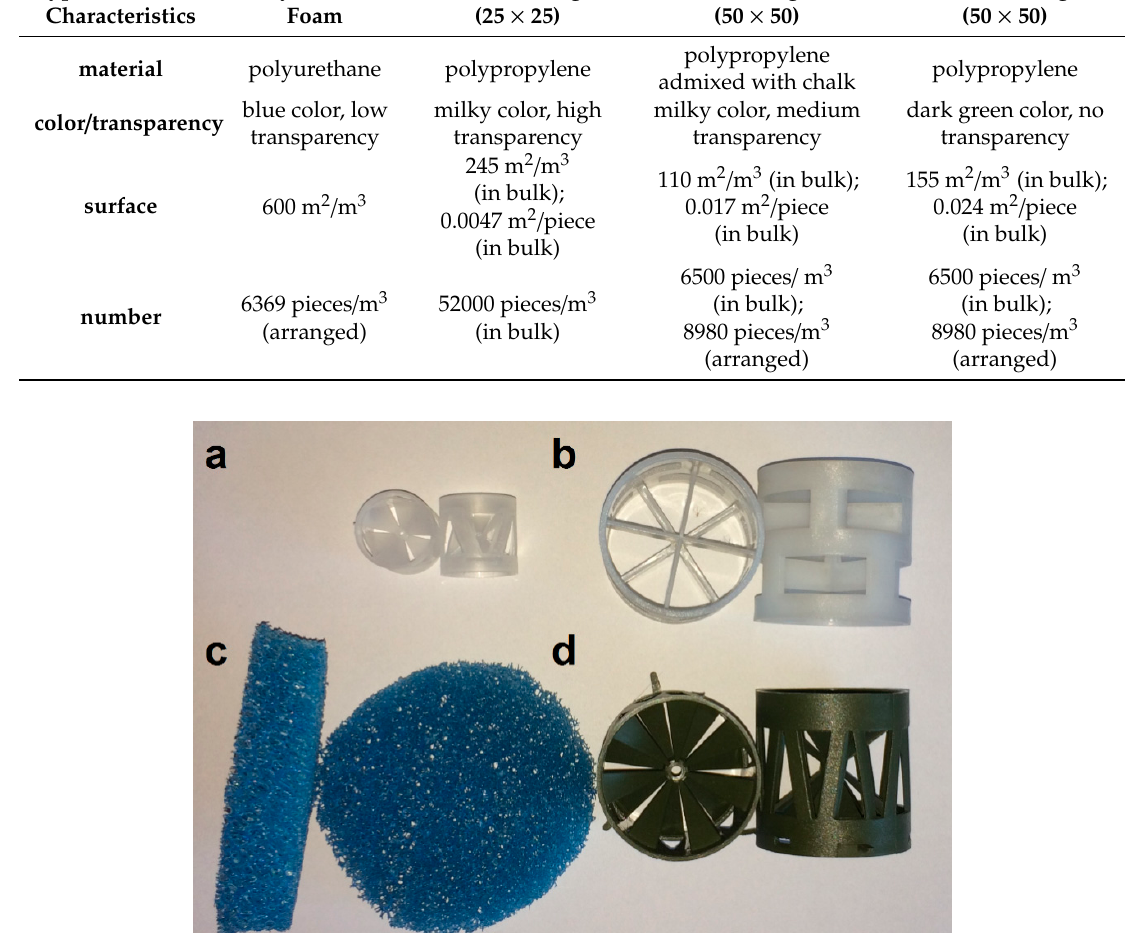
Figure1. Selectedexaminedsupportmaterials. ( a )Bialeckirings(25 × 25), ( b )Pallrings, ( c )polyurethane foams, ( d ) Bialecki rings (50 × Figure 1. Selected examined support materials. ( a ) Bialecki rings (25 × 25), ( b ) Pall rings, ( c ) polyurethane foams, ( d ) Bialecki rings (50 × 50).